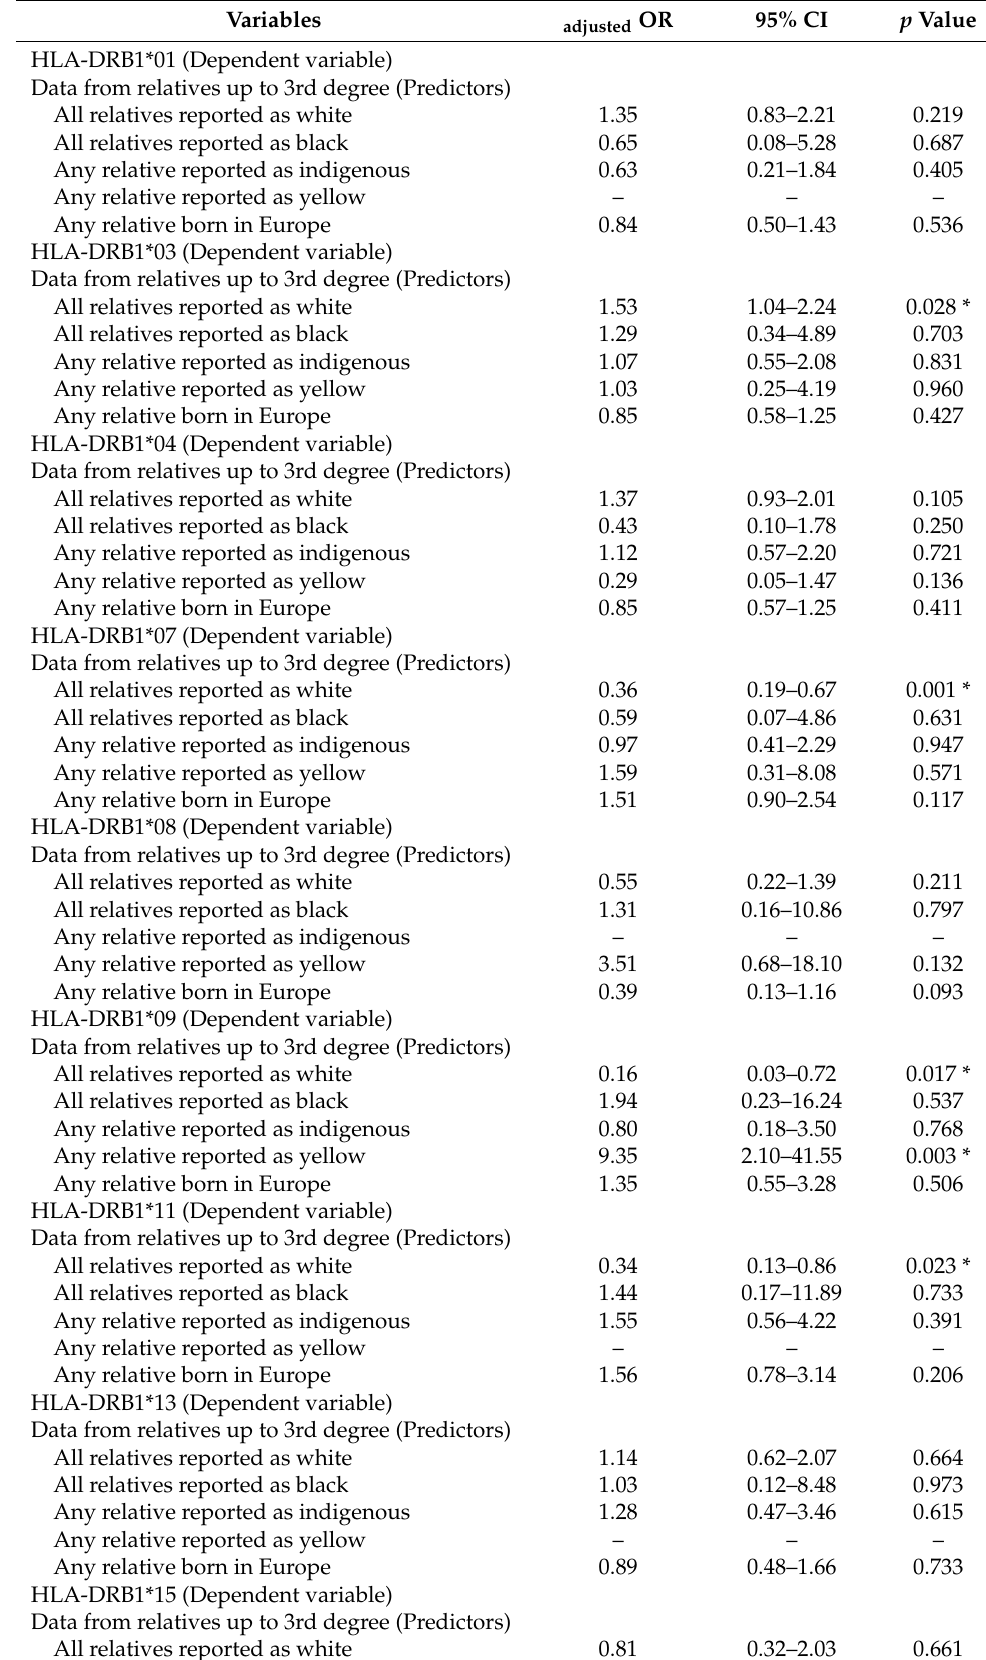
Table 3. Multiple logistic regression of predictors of HLA-DRB1* alleles in the study sample. Variables adjusted